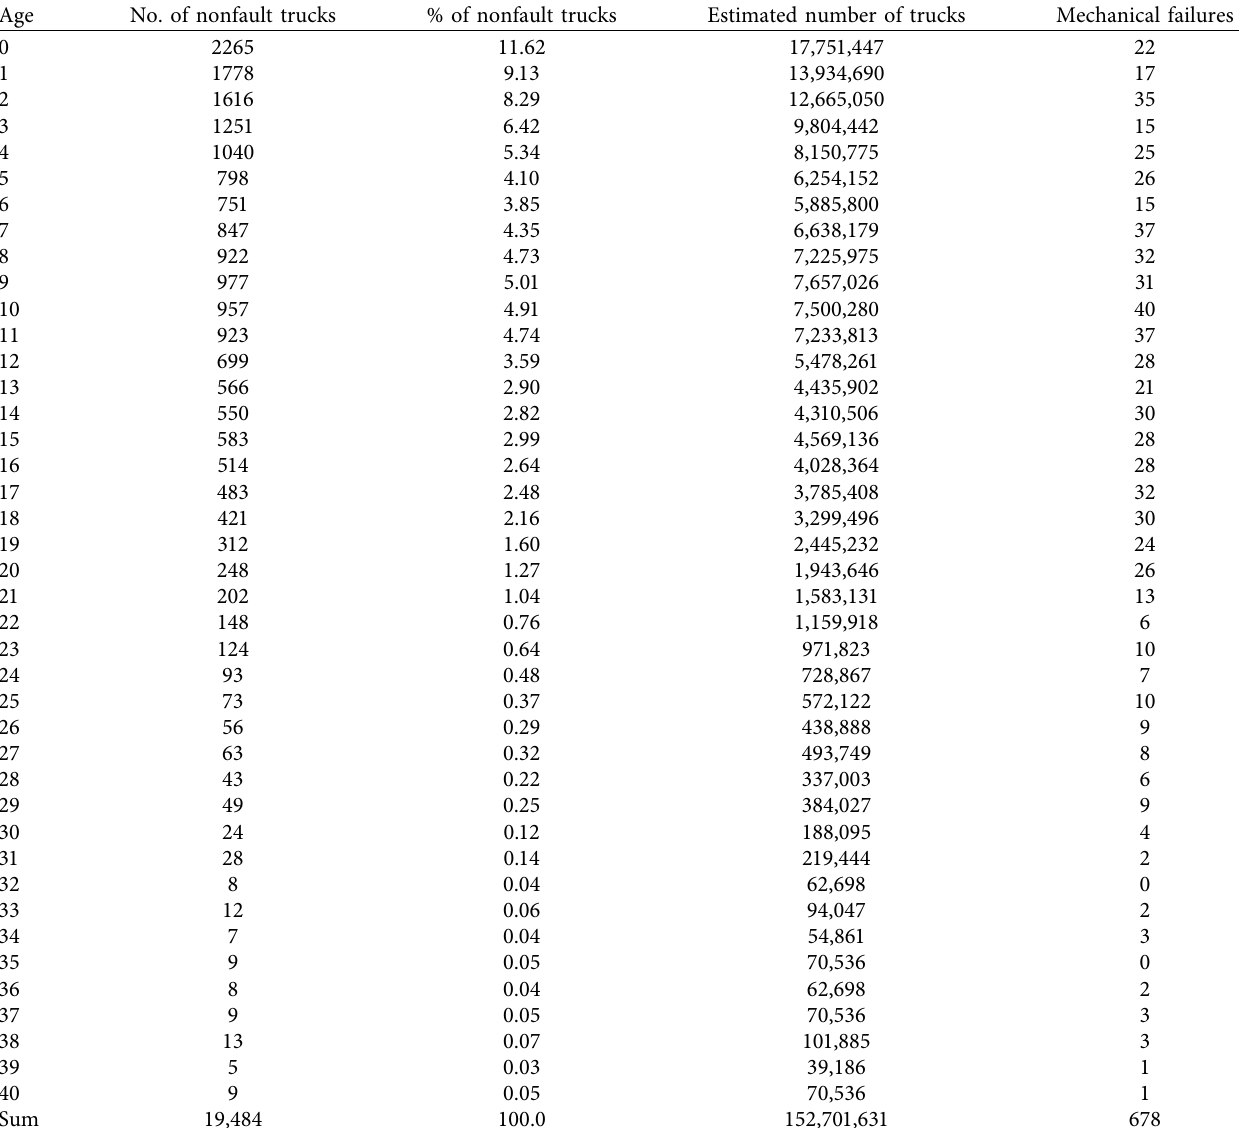
Table 4: Estimated trucks from the quasi-induced exposure method.